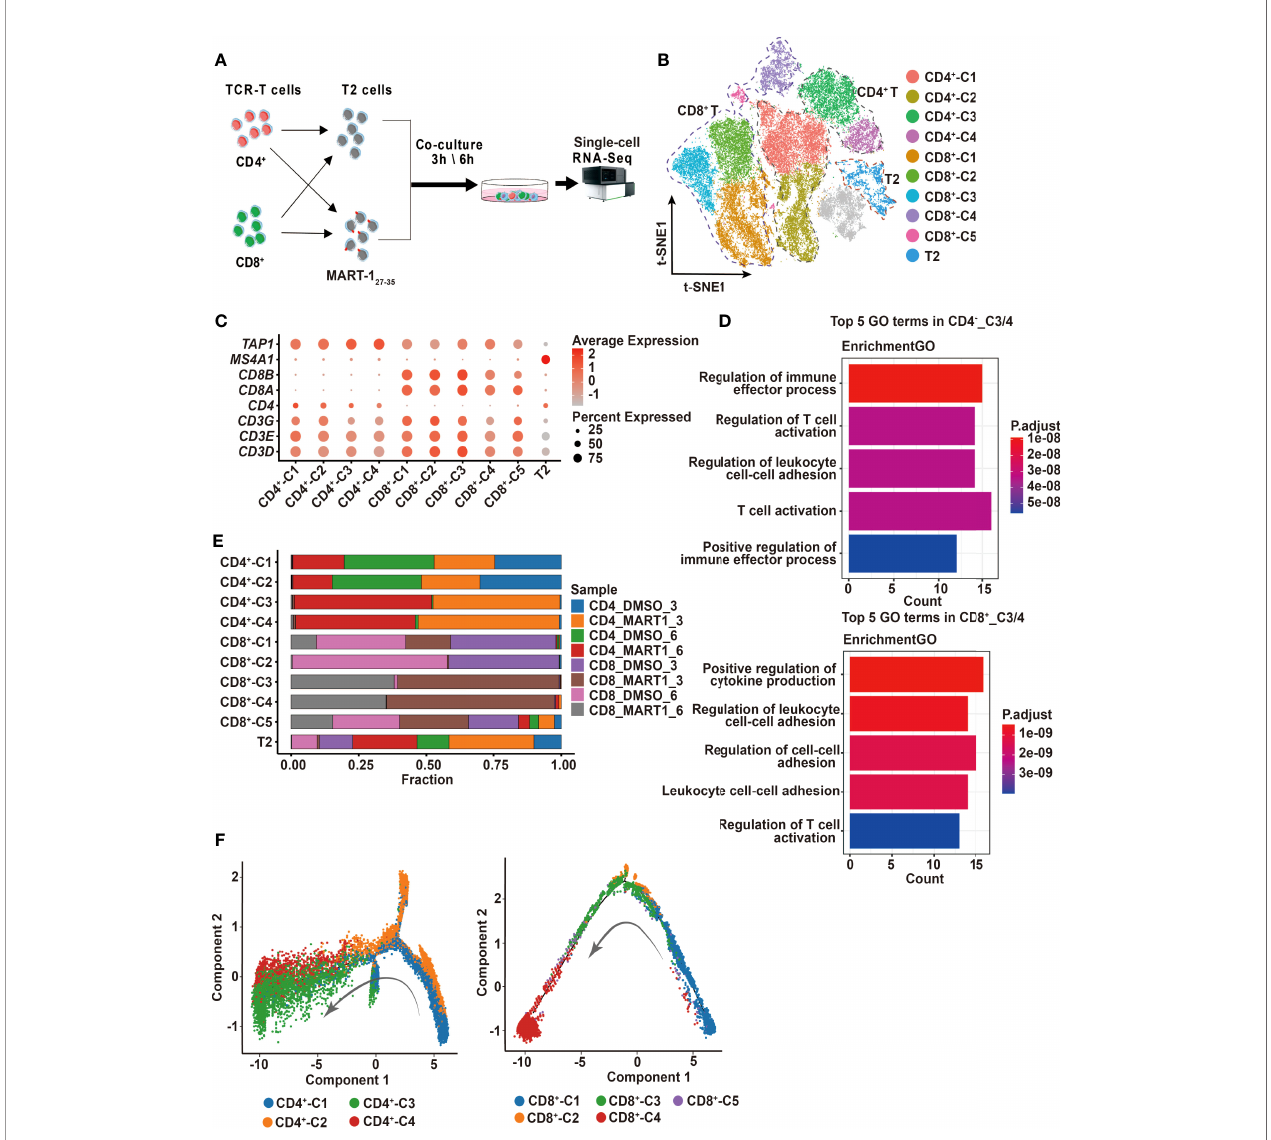
FIGURE 2 | Single-cell pro fi ling of CD4 + and CD8 + TCR-Ts cocultured with target cells. (A) Flow chart of the single-cell RNA sequencing experimental design. (B) t-SNE visualization of the expression pro fi les of the 43,368 cells that passed quality control. Clusters pertaining to CD8 + T cells, CD4 + T cells and T2 cells were illustrated by dotted lines. Grey refers to unde fi ned cells. (C) Dot plot depicting the average expression and percent of cells expression maker genes for each given cluster. CD3D/E/G for T cells, CD4 for CD4 + T cells, and CD8A/B for CD8 + T cells. TAP1 and MS4A1 are negative and positive markers of T2 cells, respectively. (D) GO pathway analysis of CD4 + _C3/C4, CD8 + _C3/C4 compared with CD4 + _C1/C2 or CD8 + _C1/C2/C5 (FC > 1.0, P < 0.05). The color key from red to blue indicates P values from low to high. Count represents the number of genes enriched to this GO entry from the input gene for enrichment analysis. (E) Stacked bar chart of sample proportions in each cluster. (F) Pseudotime trajectory plots of CD4 + T (left) or CD8 + T cells (right) across the pseudotime trajectory. Each point corresponds to one single cell. Each color represents one cell cluster. GO, gene ontology. t-SNE, t-distributed stochastic neighbor